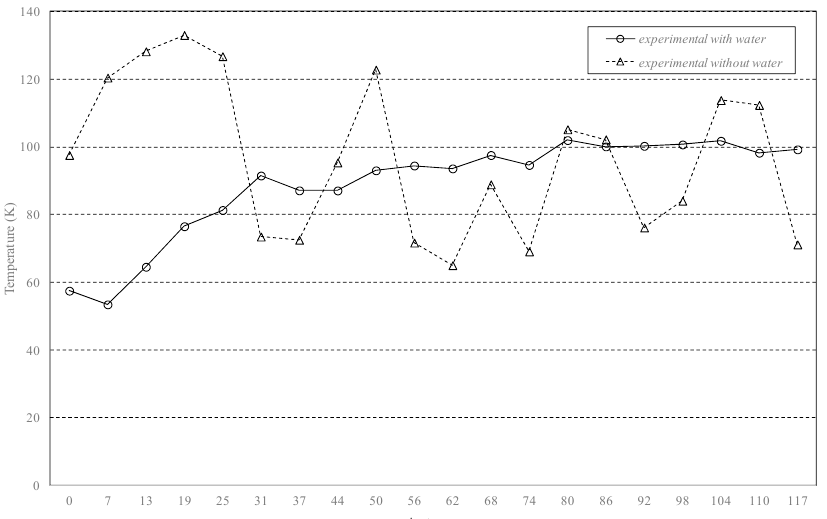
Figure 9. Experimental analysis of the linear focus system with and without fluid in the circuit.